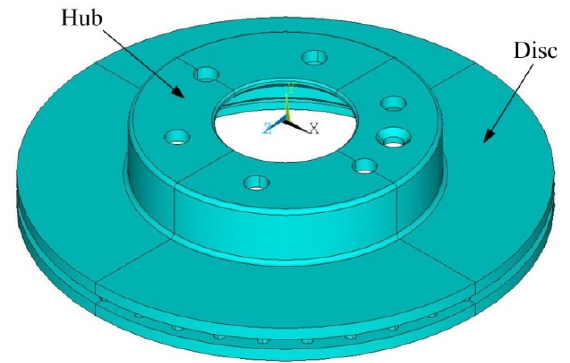
Figure 2. Geometry of a vented brake rotor.